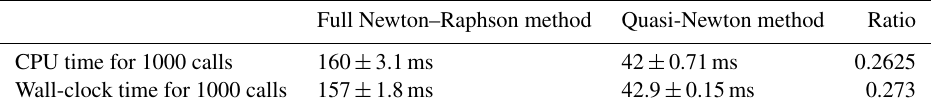
Table 2. Wall-clock times for running 1000 calls for the NR iterations and QN iteration within the UKCA_BOX model run on a single processor